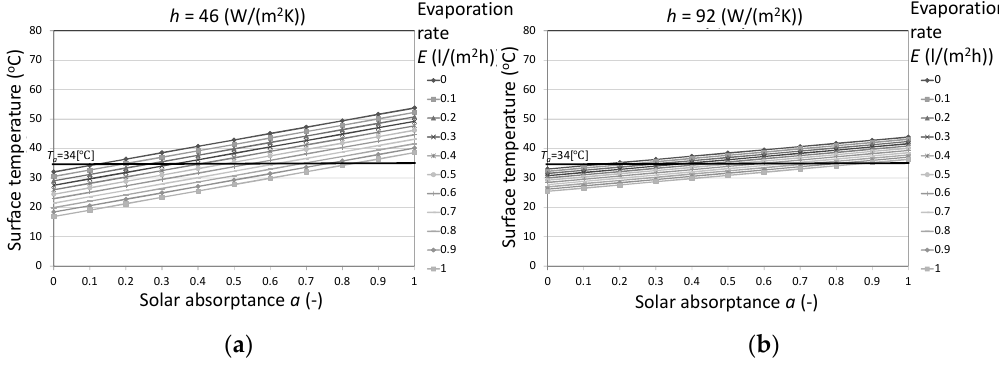
Figure 9. Surface temperature T s when the heat transfer coefficient ( a ) h is 46, ( b ) h is 92 W/(m 2 K). The relationship between the MRT reduction and the solar absorptance a when the evaporation rate E is 0 L/(m 2 h) for different values of the shape factor Φ of the human body is shown in Figure 10. When the shape factor Φ and solar absorptance a were large, the MRT increased due to the effect of long-wave radiation from the adaptation measures.